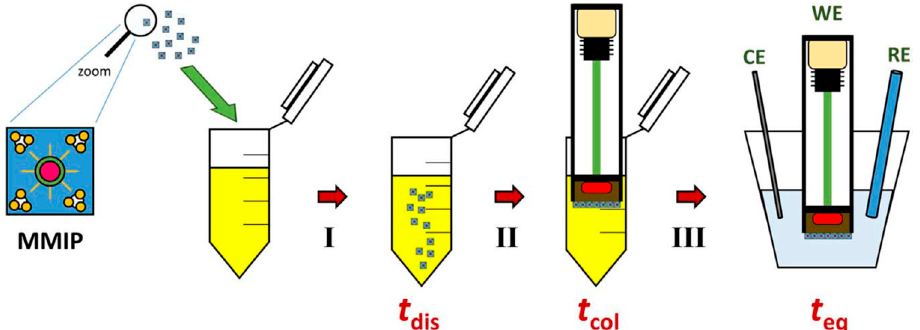
Figure 14. Schematic of the analytical procedure after placing the Mag-MIPs: (I) dispersion of the mag-MIPs (dispersion in a 3 mg mL − 1 glycine buffer solution, at a pH of 2.0, 0.1 mol L − 1 , Tween 20, 0.05%, and NaCl 0.15 mol L − 1 ); (II) magnetic capture by the magneto-sensor; (III) analyte binding to the mag-MIPs (in a 20 mL solution: 9 mL of sample, 9 mL of phosphate buffer solution, and 2 mL of ethanol). Reprinted from [55], with permission from Elsevier, 2018.